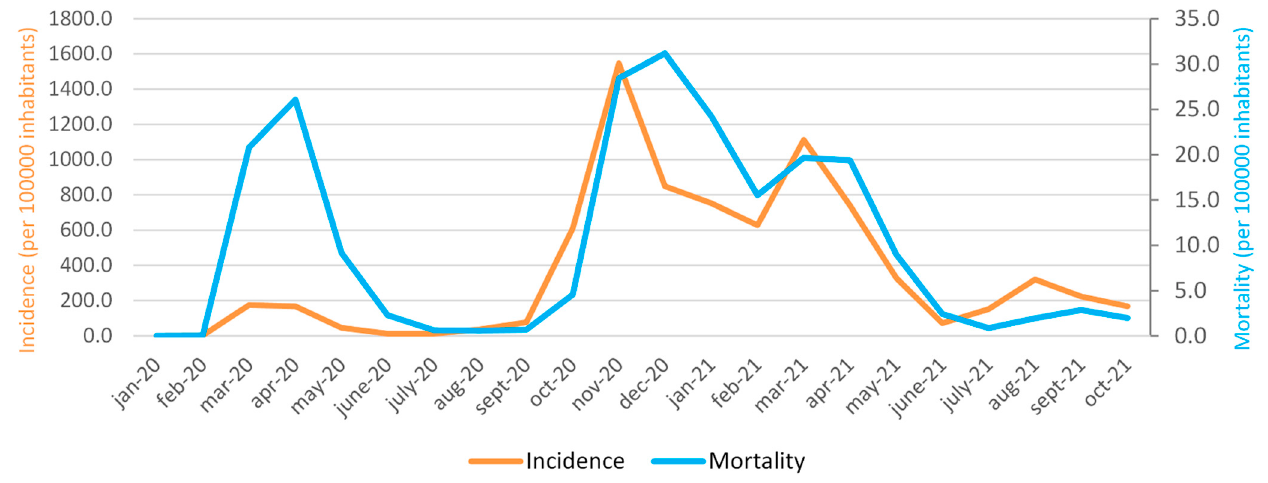
Figure 1. The cumulative monthly incidence trend of Italy per 100,000 inhabitants in the period January 2020–October 2021 is shown in orange (left abscissa axis, scale range 0.0–1800.0). The monthly mortality per 100,000 inhabitants in the same reference period is represented in blue (right abscissa axis, scale range 0.0–35.0).